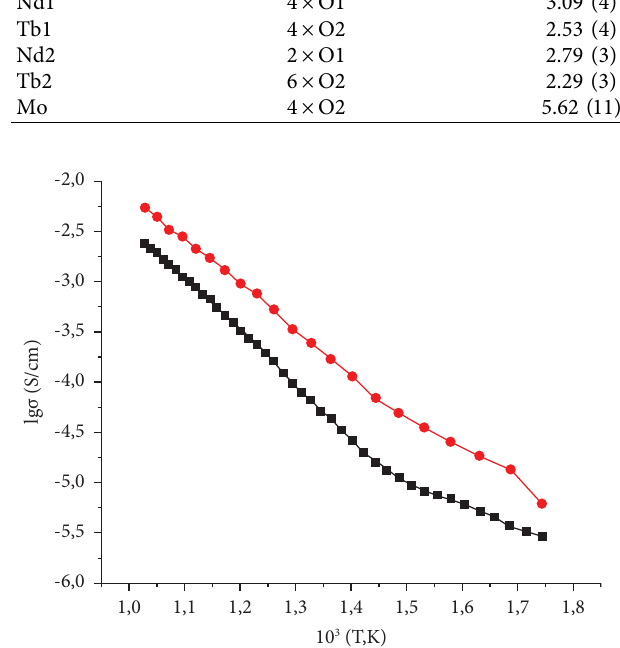
Figure 8: Temperature dependence of conductivity for samples of the Nd 5 Mo 3 O 16+ δ molybdate ( ( ) ) and the Nd 4.7 Tb 0.3 Mo 3 O 16+ δ solid solution ( (■) ).